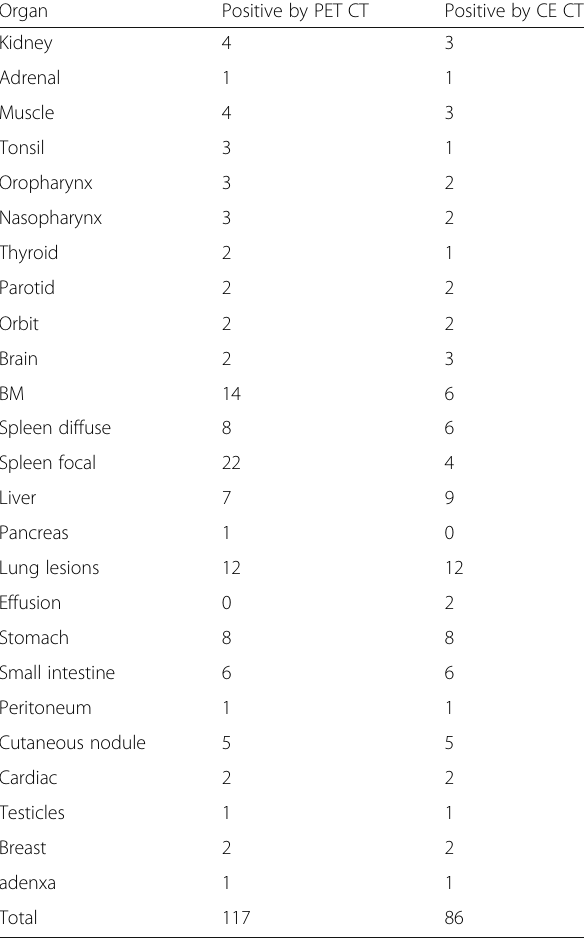
Table 3 Relation between SUV and histopathological subtypes Type